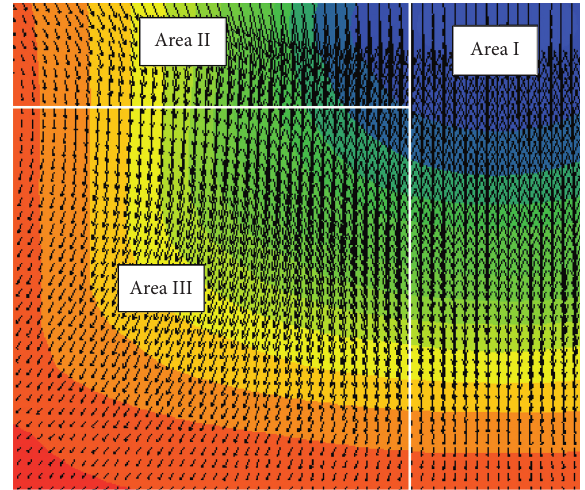
Figure 10: The z -directional displacement vector at the section of y � 0.